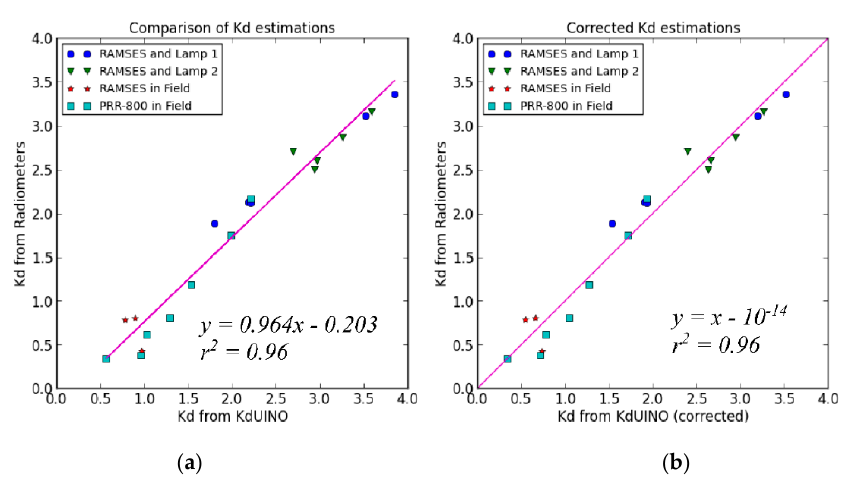
Figure 13. ( a ) Comparison of K d results derived from commercial instruments: the hyper-spectral RAMSES radiometer and the PRR-800, and the KdUINO; ( b ) Same comparison after spectral response compensation of the original KdUINO measurements (see text).